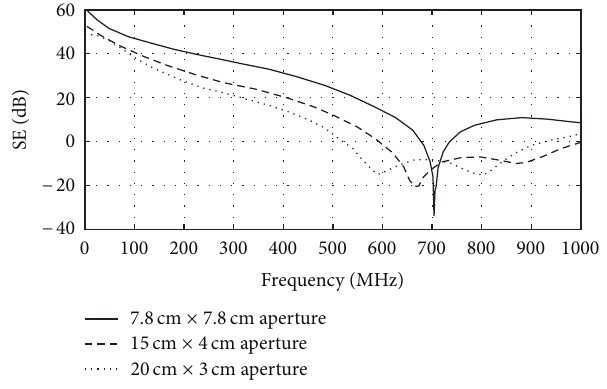
with a single slot 12 30cm 3 × ×